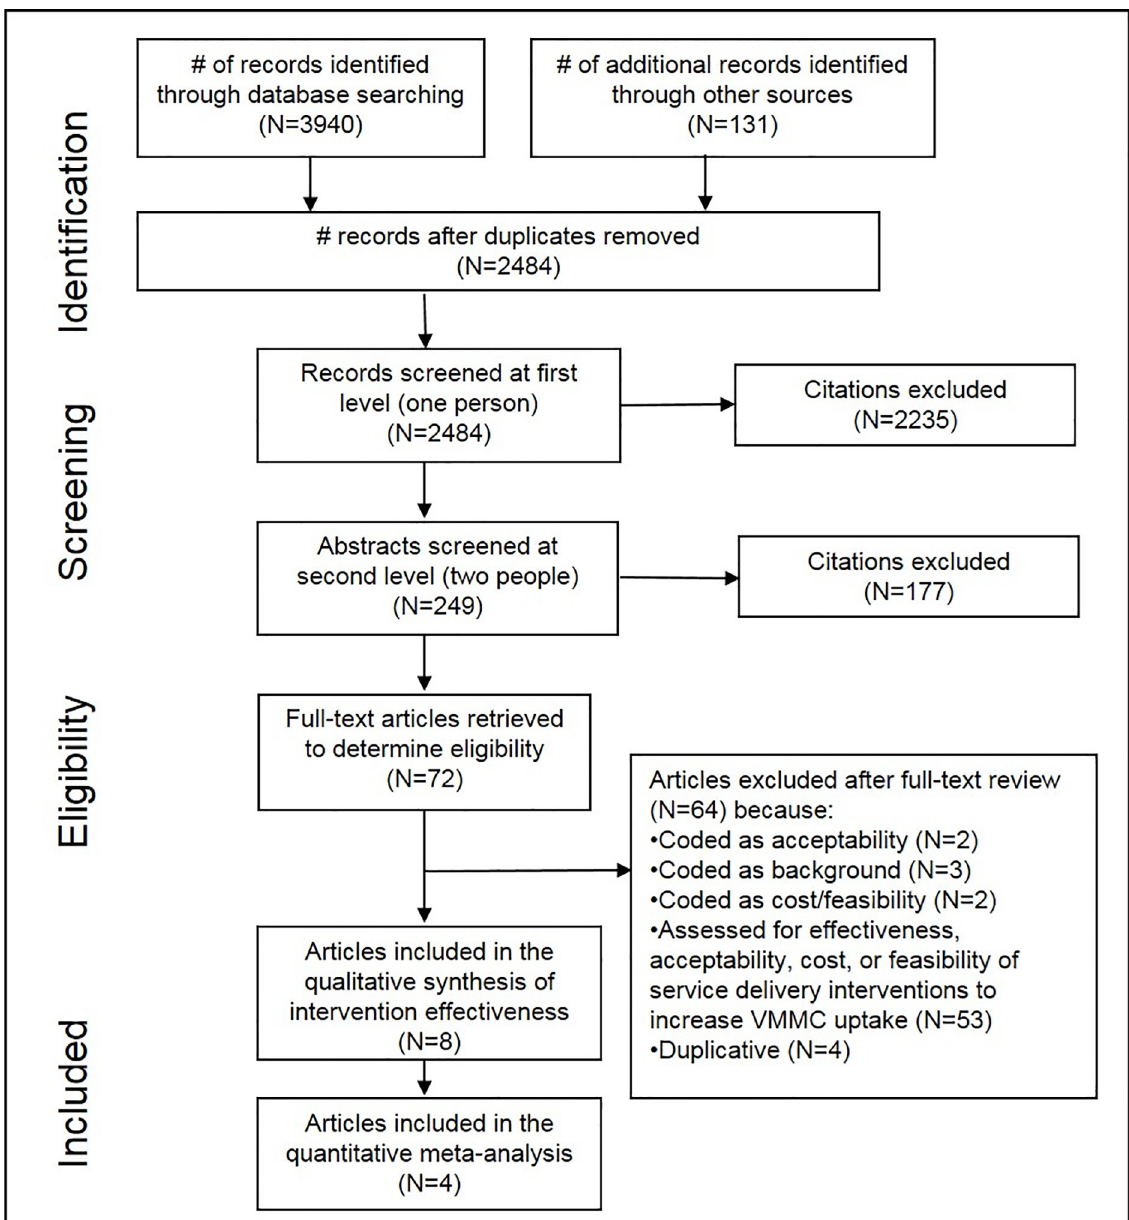
Fig 1. Flow of information through the different phases of a systematic